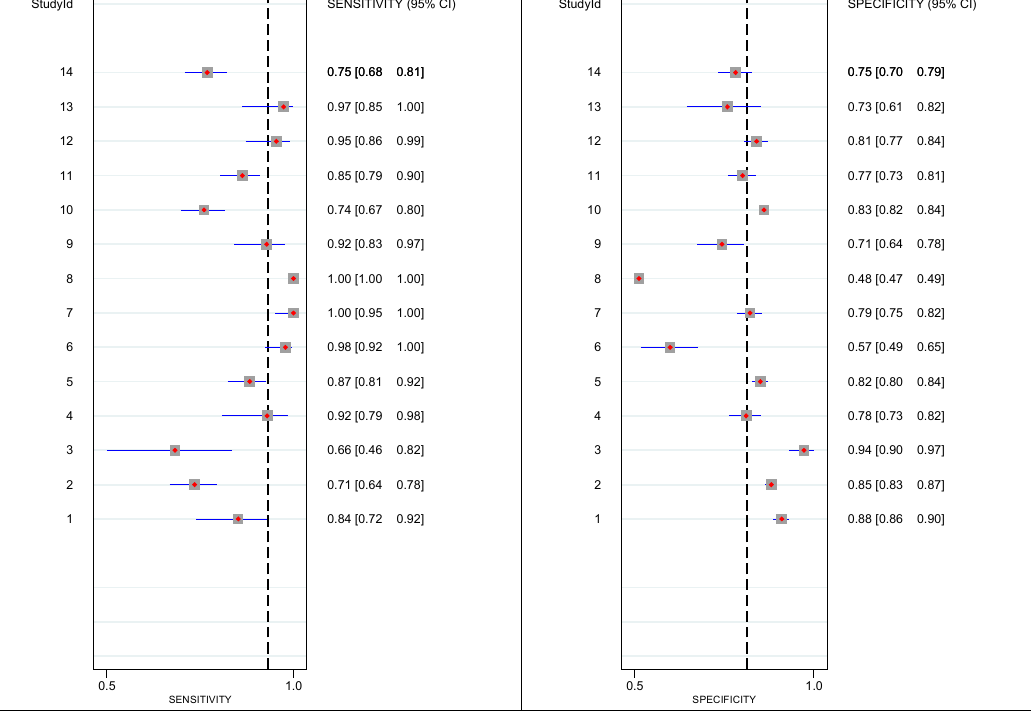
Figure 2. Plot of the study-specific sensitivity and specificity (red points) and their corresponding 95% exact confidence intervals (thick blue lines), for the AUDIT-C